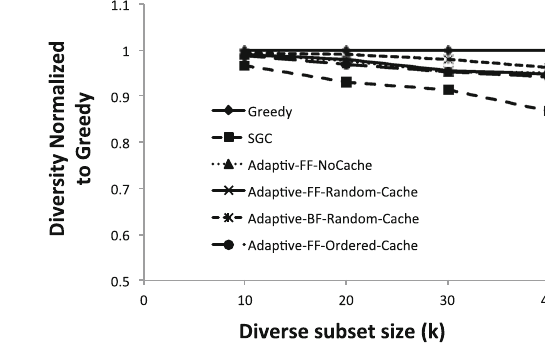
Fig. 12 Impact of varying k on cost